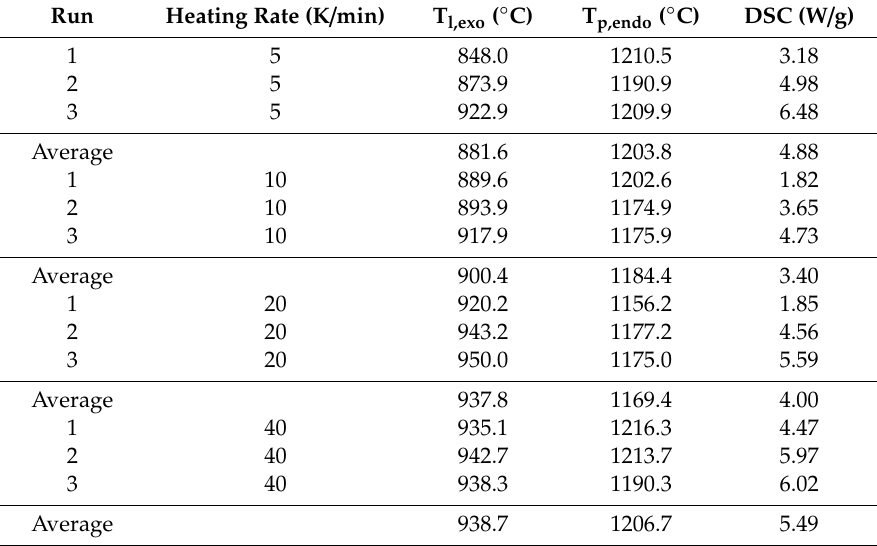
Table 2. The recorded temperatures at the exothermic (T l,exo ) and endothermic (T p,endo ) DSC peaks of Figure 12 and the recorded heat flows at the peaks for each